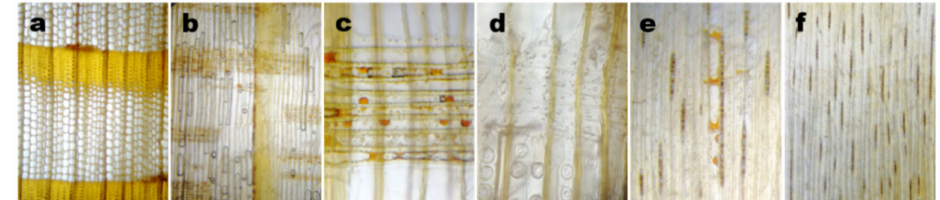
Figure 8. Microscopic morphology of the wood sample. ( a ) Non-porous wood; rapid change from early wood to late wood. ( b ) Axial parenchyma like a wheel border. ( c ) The horizontal wall pits of the ray parenchyma cells and the nodular thickening of the end wall are obvious. ( d ) Cross-field cypress wood pattern. ( e ) The end wall of the axial parenchyma cell end wall is obviously thickened. ( f ) Single row of wooden